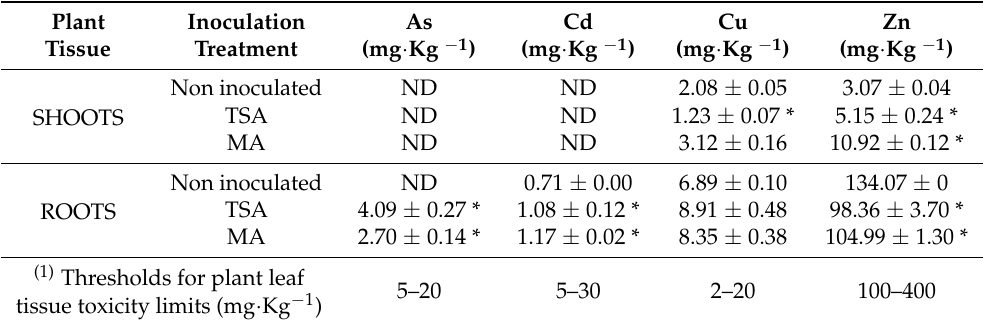
Table 4. Accumulation of arsenic and heavy metals in shoots and roots of M. crystallinum plants grown in the presence of a mixture of 10 µ M As + 1 µ M Cd + 20 µ M Cu + 50 µ M Zn, inoculated with TSA or MA SynComs. Data are means ± standard deviations of three independent determinations. Statistically significant differences with regard to the control plants in the absence of metals are indicated by asterisks. ND: